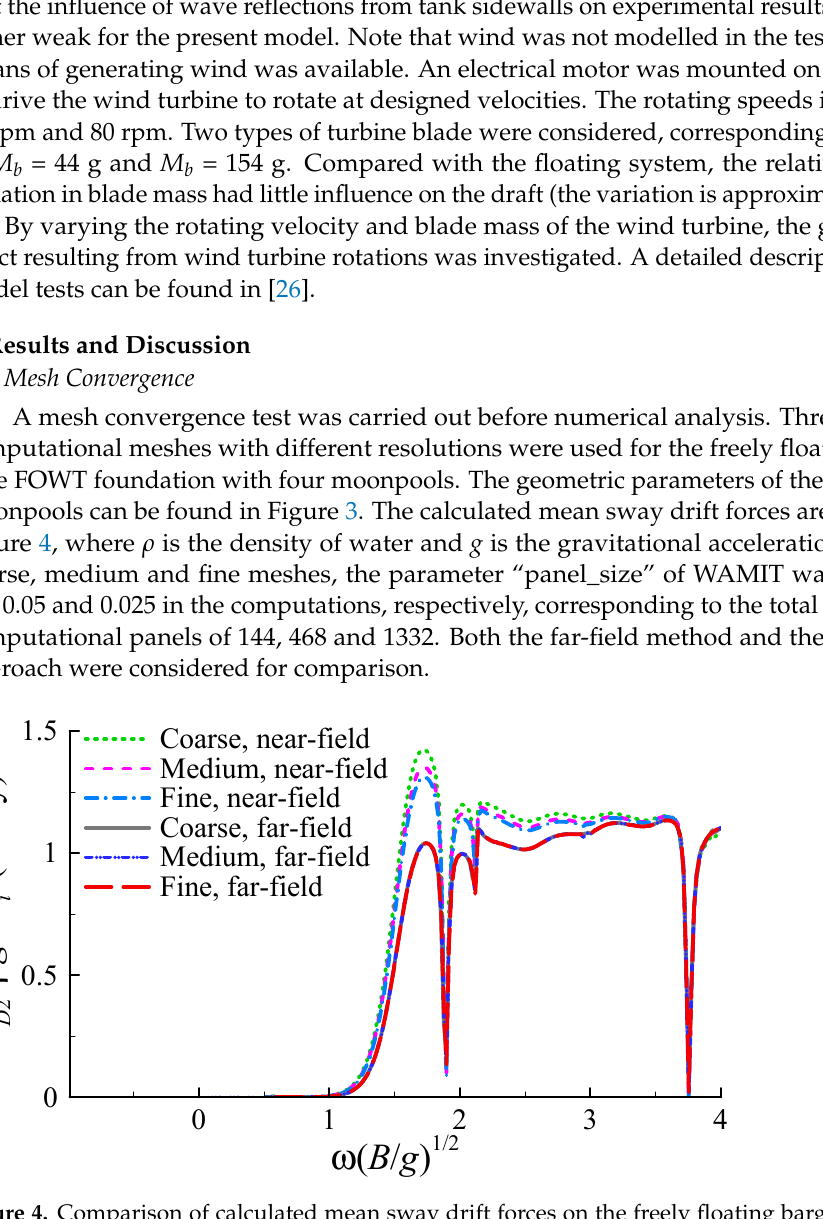
Figure 4. Comparison of calculated mean sway drift forces on the freely floating barge with four moonpools using the near-field and far-field methods with different mesh resolutions.